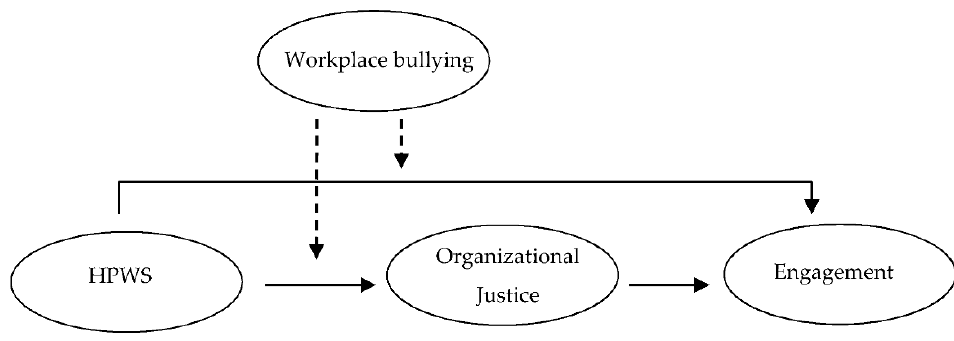
Figure 1. Hypothesized research model.